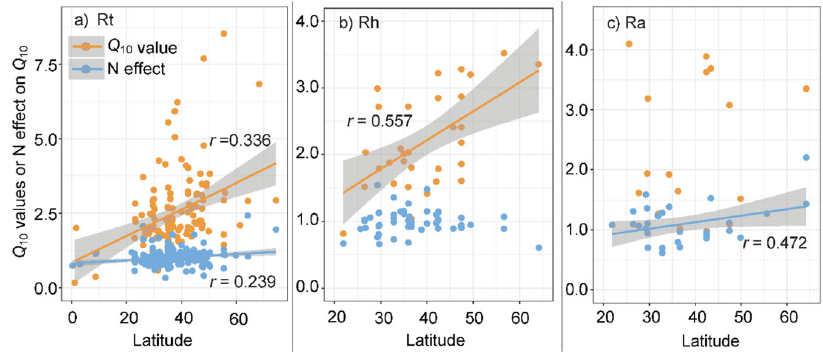
Fig. 1 Geographical pattern of the temperature sensitivity of soil respiration and their responses to nitrogen enrichment. Latitudinal distribution of the temperature sensitivity of total soil respiration ( a ), heterotrophic respiration ( b ), and autotrophic respiration ( c ), and their responses to nitrogen enrichment. The solid black line represents the fi tted regression line, and the gray shading represents their 95% con fi dence band. All relationships showed are signi fi cant at a level